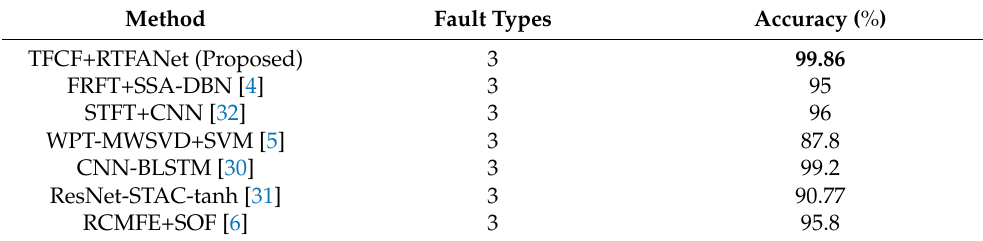
Table 5. Comparison with other rolling bearing fault diagnosis methods.